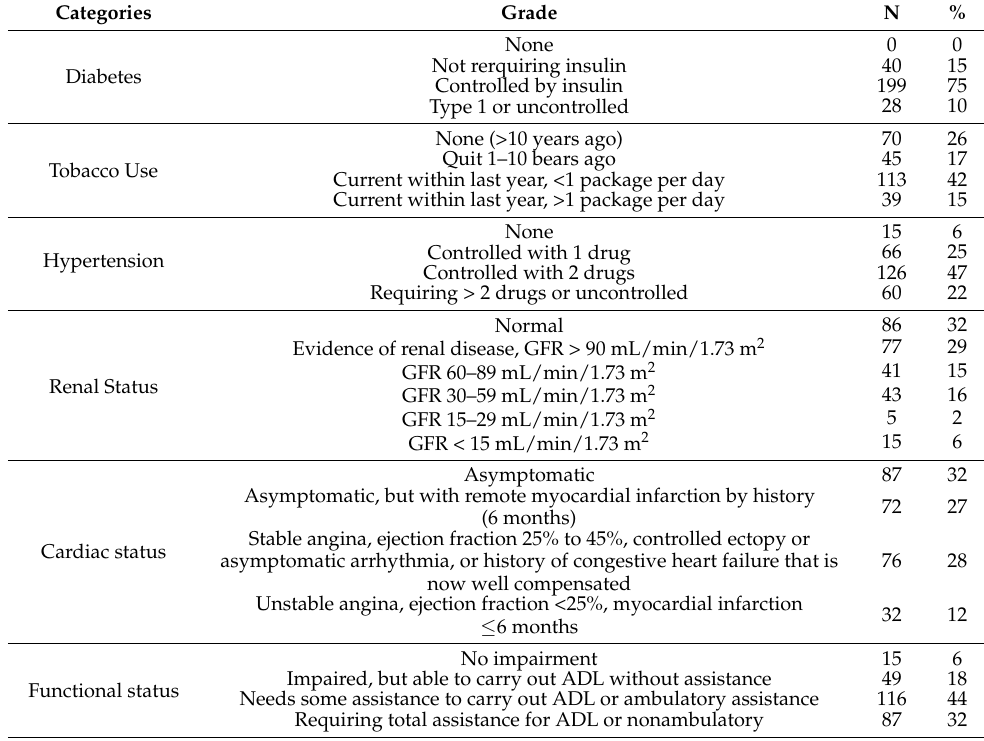
Table 1. Nonanatomic patient